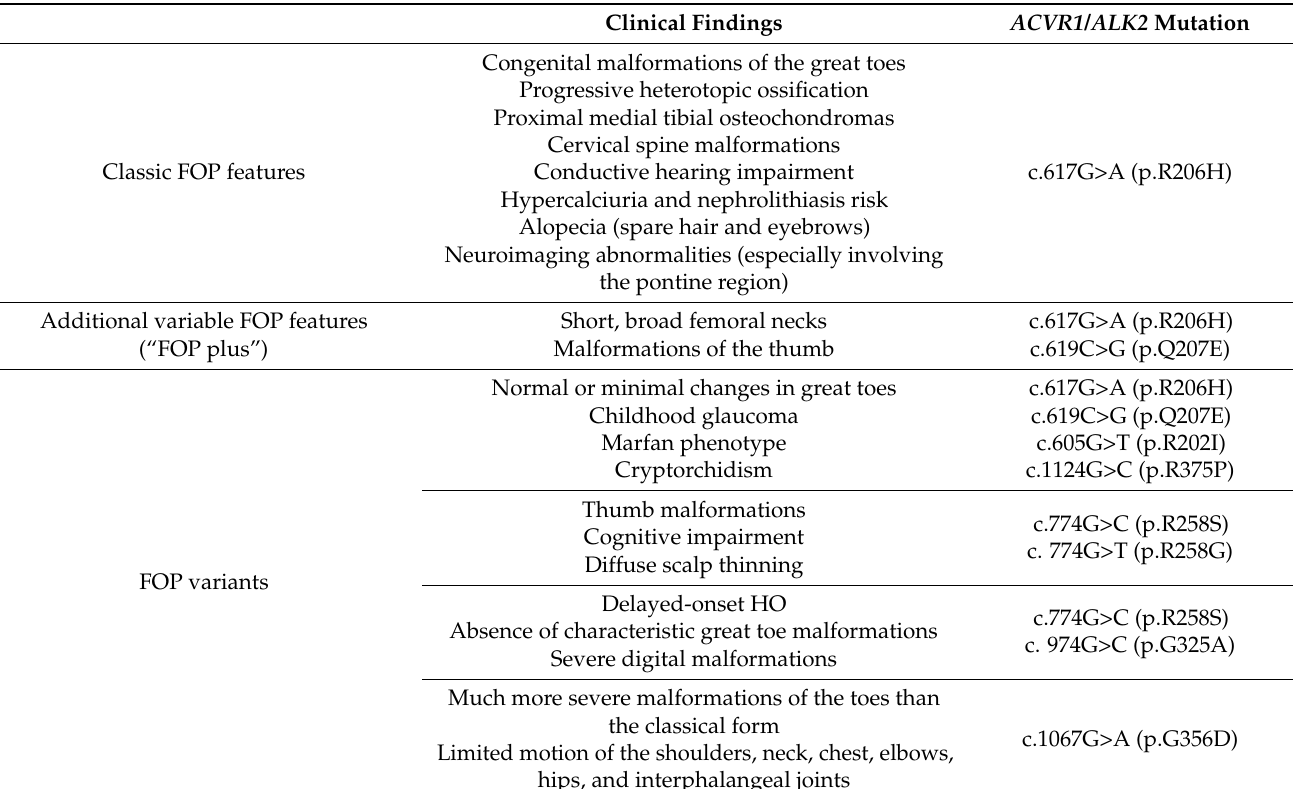
Table 1. Classification of FOP, according to clinical features and type of